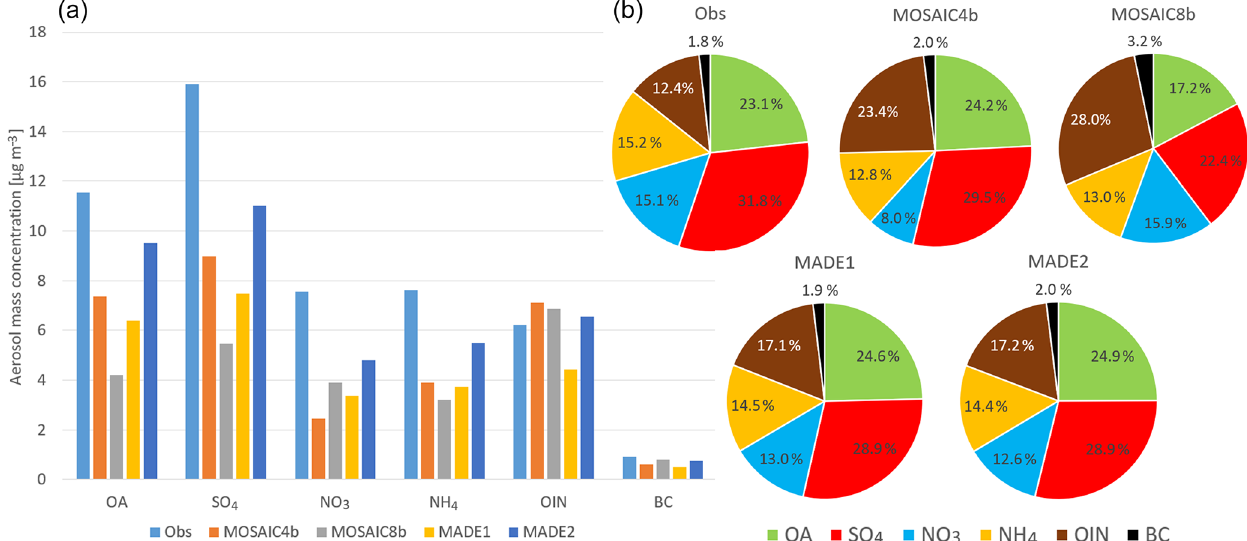
Figure 13. (a) Bar plot showing submicron aerosol mass concentration by species for observations (AMS + SP2) and retrospective simula- tions. (b) Pie charts showing the percentage contribution by each species for observations and retrospective